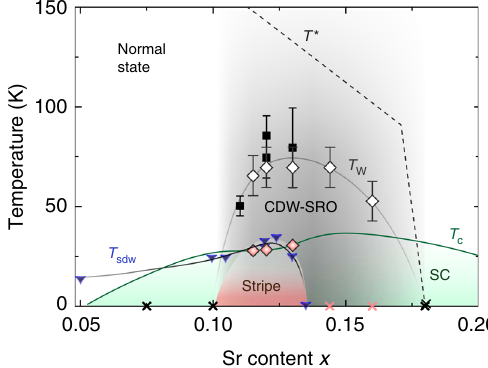
Fig. 1 Phase diagram of LSCO. A sketch of the LSCO phase diagram. The open and fi lled diamonds denote T w and the onset temperature of CDW stripe order determined in this study, respectively. The error bar of T w is estimated to be 10 K. The fi lled squares are the CDW onset temperature reported in previous X-ray scattering studies 31,39 . T sdw is the SDW onset temperature determined from neutron scattering measurements 9,39 . T c is the superconducting transition temperature 39 and T * is the pseudogap temperature 43 . The black and red cross symbols indicate the doping levels where no CDW-SRO or CDW stripe order have been detected in this study,